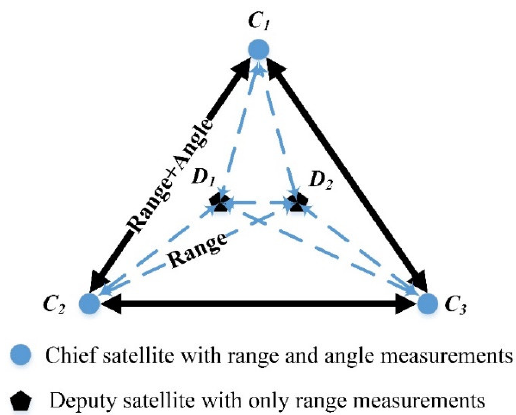
Figure 1. The multi-satellite relative navigation scheme.